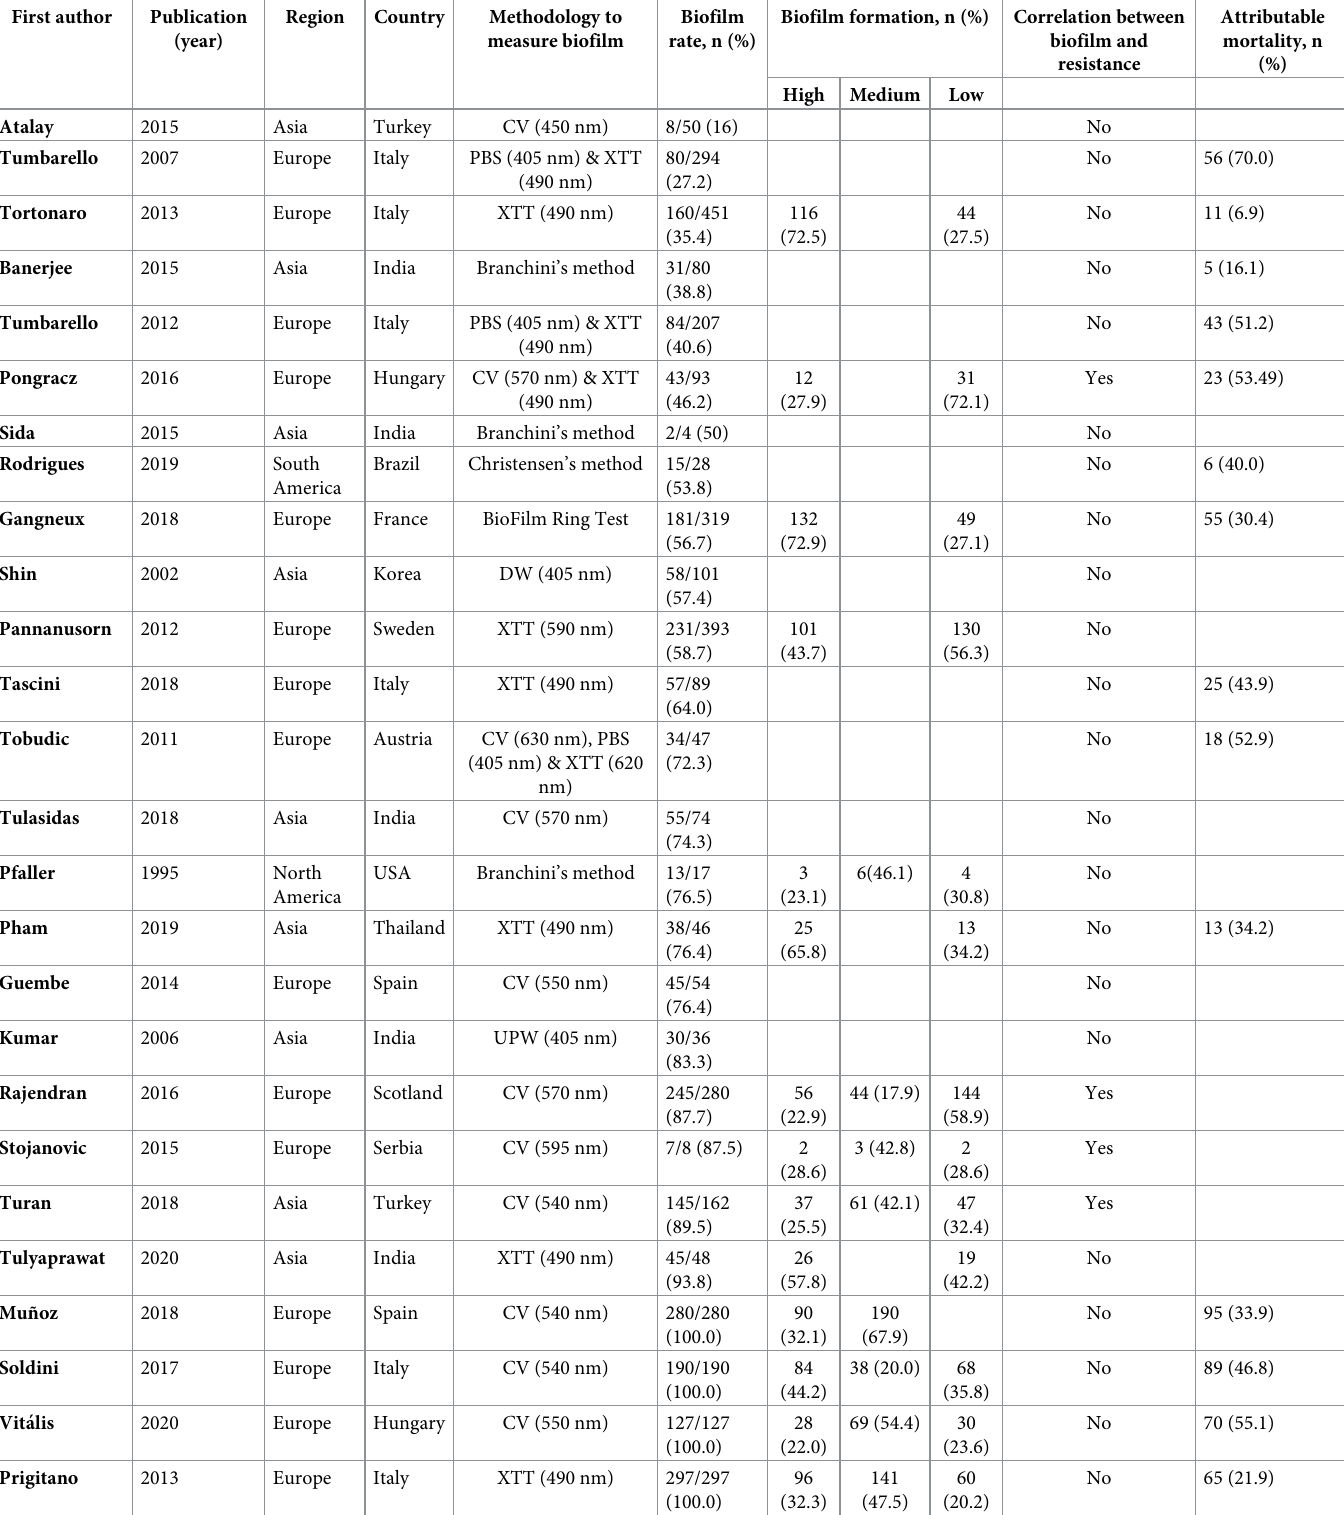
Table 1. General information extracted from the data set selected for the present